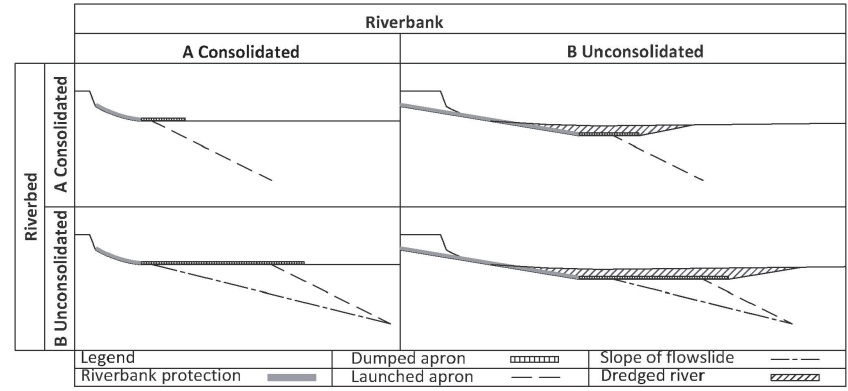
Figure 15. Comparison of riverbank protection designs for different geotechnical conditions.